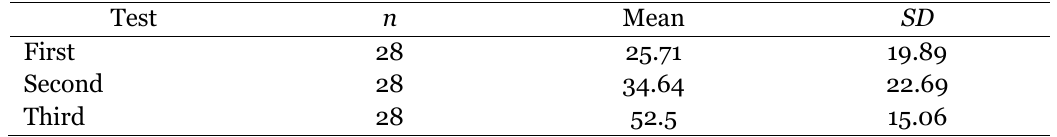
Paired Samples Statistics for the Three Tests in Experiment 2